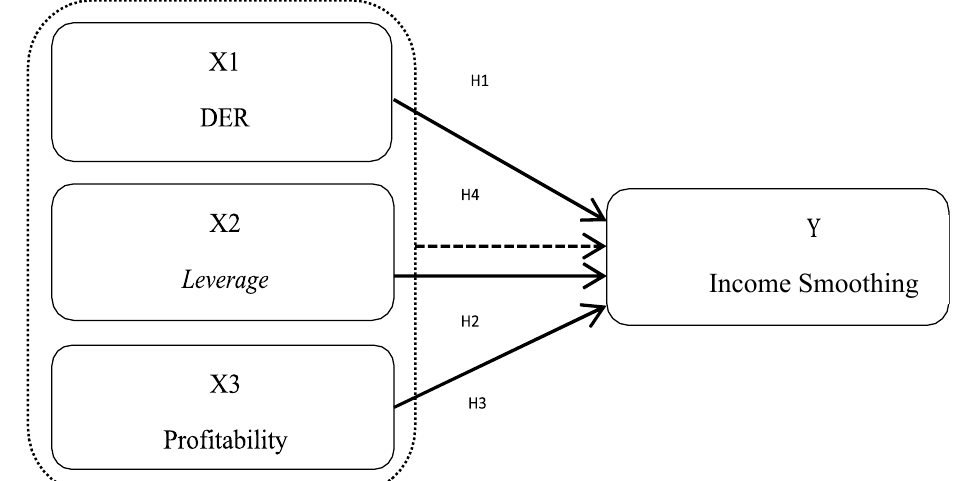
Fig. 1. Research Model